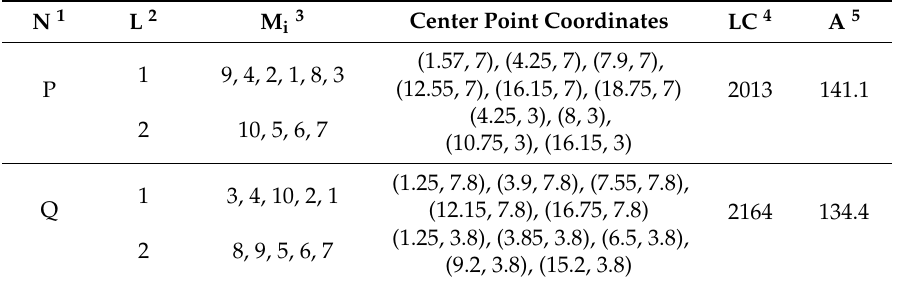
Figure 8. Schematic diagram of Pareto set comparison. Table 9. Display of partial